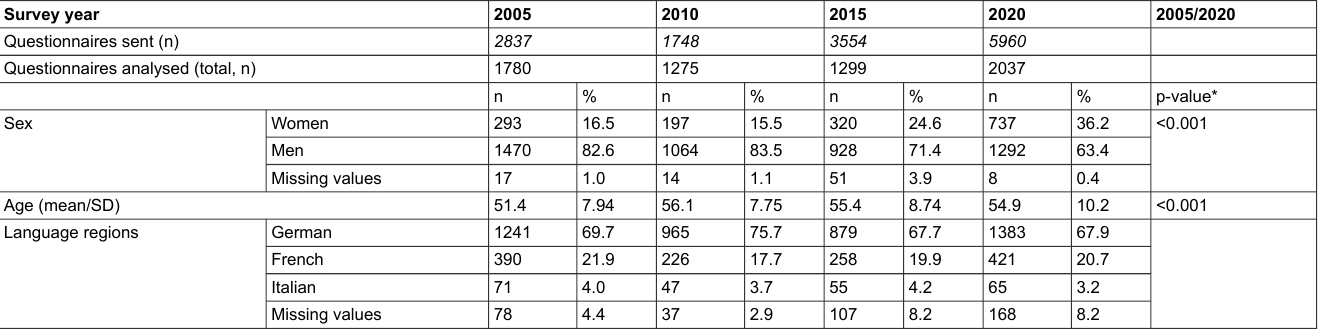
Table 2: Demographic characteristics of participants of the surveys in 2005, 2010, 2015 and 2020.